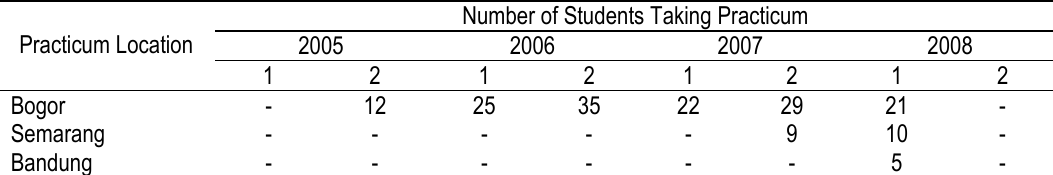
Table 1. Number of students taking practicum 2005-2008 Number of Students Taking